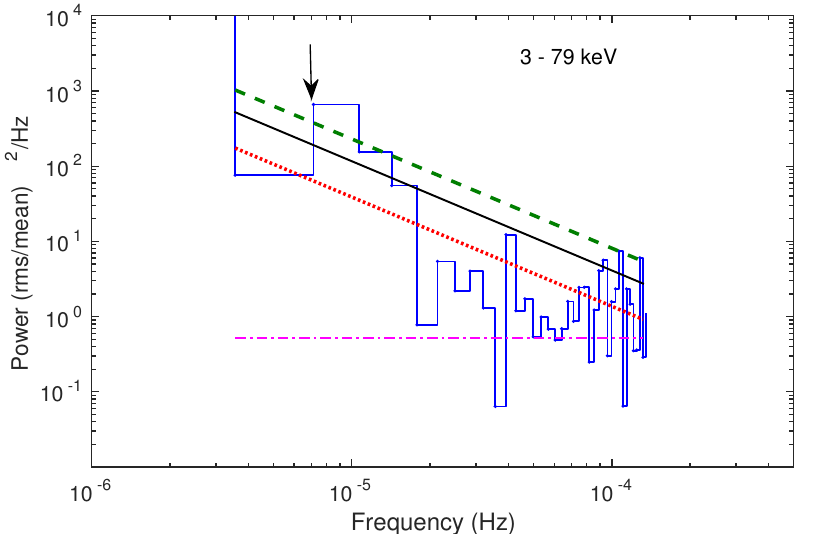
Figure 3. Fourier spectrum of 3C 120 in the 3–79 keV band. The red curve (dotted line) represents the best-fit power-law model, pink line (dash-dot) denotes the expected Poisson level, black line (solid line) gives the 95% confidence level while green (dashed line) represents the 99.73% confidence level. The arrow points towards the QPO